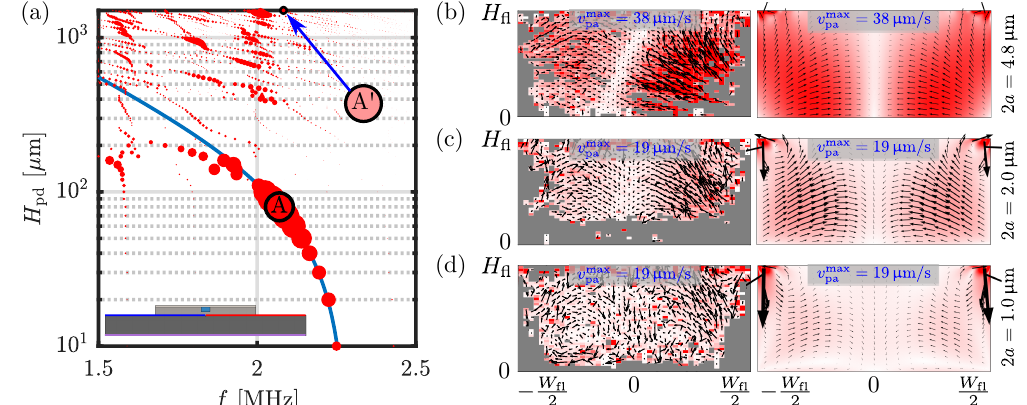
Figure 5. ( a ) Resonance peaks in the single-PDMS-cover aluminum-based device with anti-symmetric voltage actuation, Figure 4, as a function of the actuation frequency f and the thickness H pd of the PDMS cover. The area of the points is proportional to the focusing figure of merit F defined in Equation (15). The “A (cid:48) ” marks the resonance mode for H pd = 1.5 mm as in mode “S” of Figure 3. The “A” marks the resonance for the optimal cover thickness H pd = 80 µm. The blue curve indicates resonances sensitive to H pd . ( b – d ) Color and vector plot of the measured (left column) and simulated (right column) acoustophoretic particle velocity v pa of mode “A (cid:48) ”, for particle diameters 4.8, 2.0, and 1.0 µm, respectively. The measured resonance frequency was f = 2.052 MHz and the simulated was found at f = 2.095 MHz (2% higher). All color plots range from 0 µm/s (white) up to v max pa (red) with values 38 or 19 µm/s as indicated in each